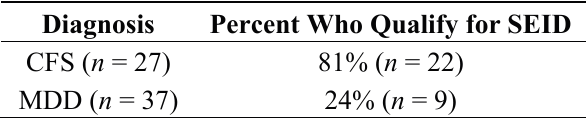
Table 4. CFS vs. MDD Database n =